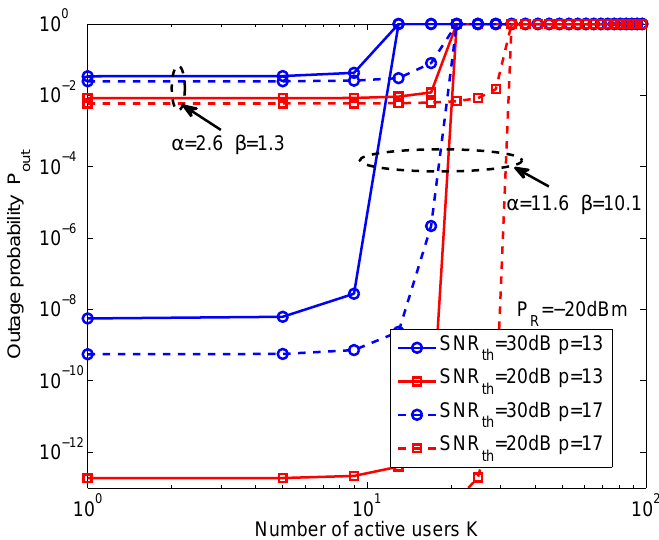
versus the number of active users K , when out